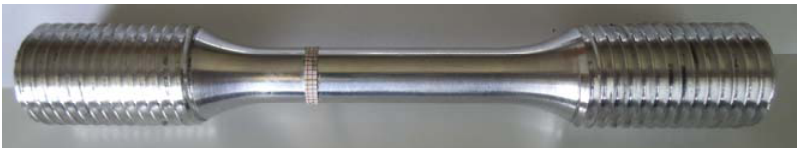
Figure 1: Specimen used for fatigue crack growth data.